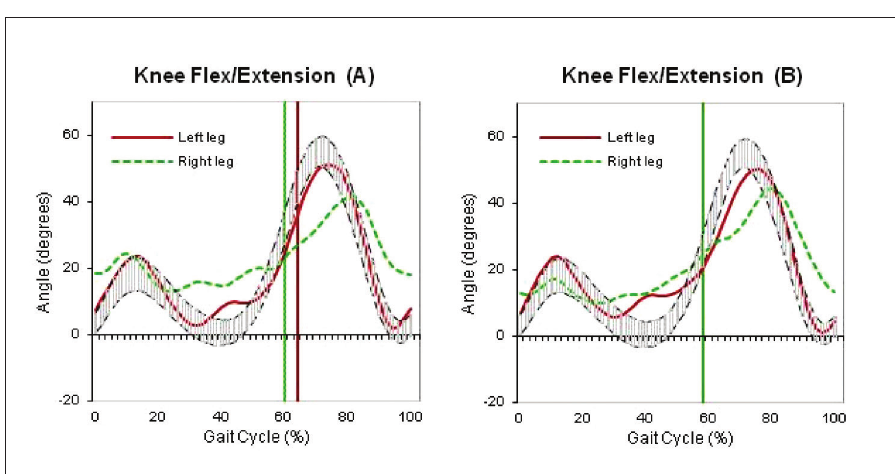
Figure 4. Knee joint